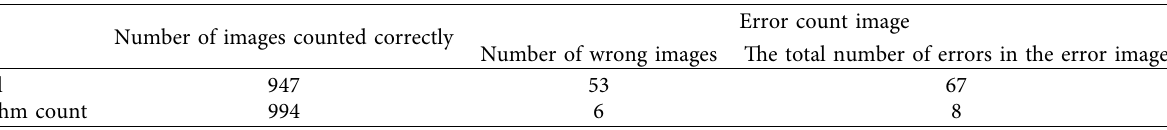
Figure 6: Count the insects in the picture. Table 2: Statistics and comparison of counting results.